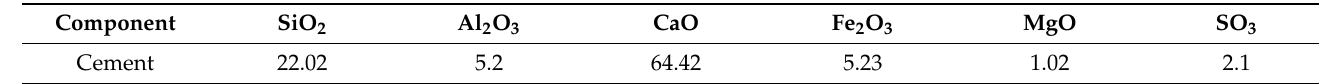
Table 1. Chemical composition of cement.